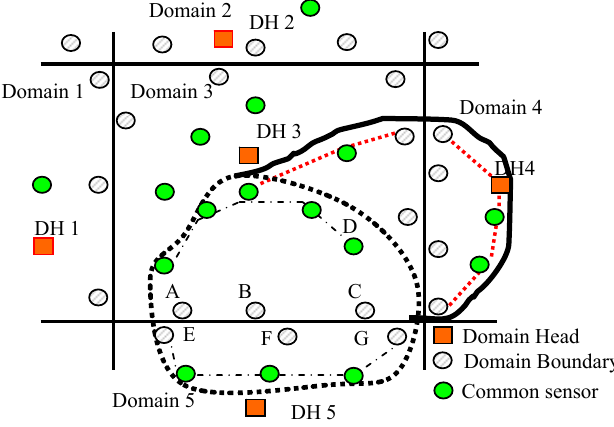
Fig.6 updating boundary sensors when heritage deformed or moving boundary After deployed and initialed, the EffeHDDT operates in the monitoring phase, the EffeHDDT detects the heritage boundary periodically. When a portion of or the whole heritage